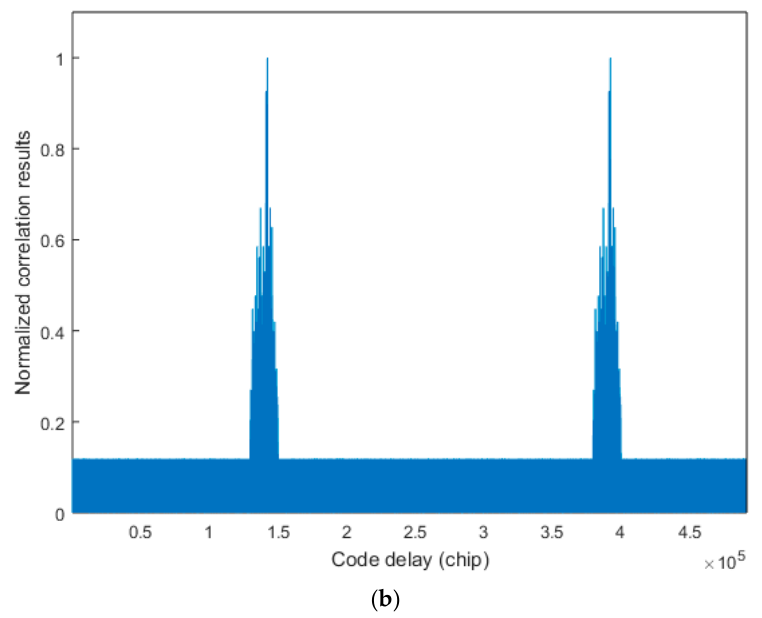
Figure 8. Correlation using the matched filter method: ( a ) autocorrelation results and ( b ) cross- correlation results.